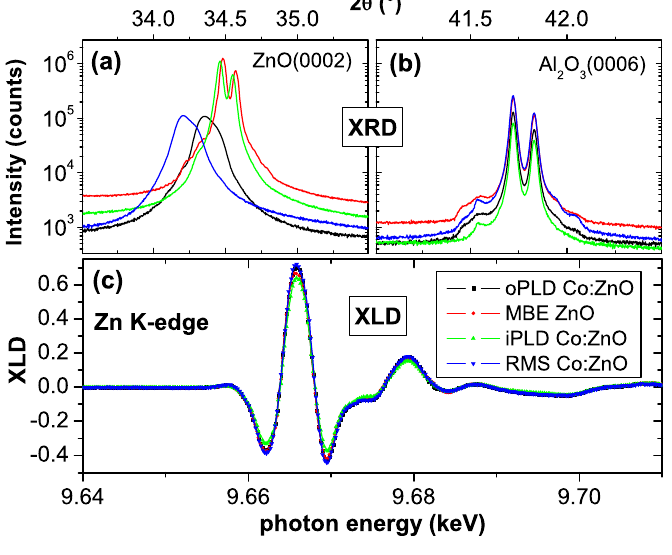
Figure 4. XRD ! -2 (cid:18) -scans for (a) the ZnO(0002) and (b) the Al reflection of three different Co:ZnO samples together with a MBE ZnO reference using non-monochromatized X-rays. (c) displays the respective XLD recorded at the Zn K